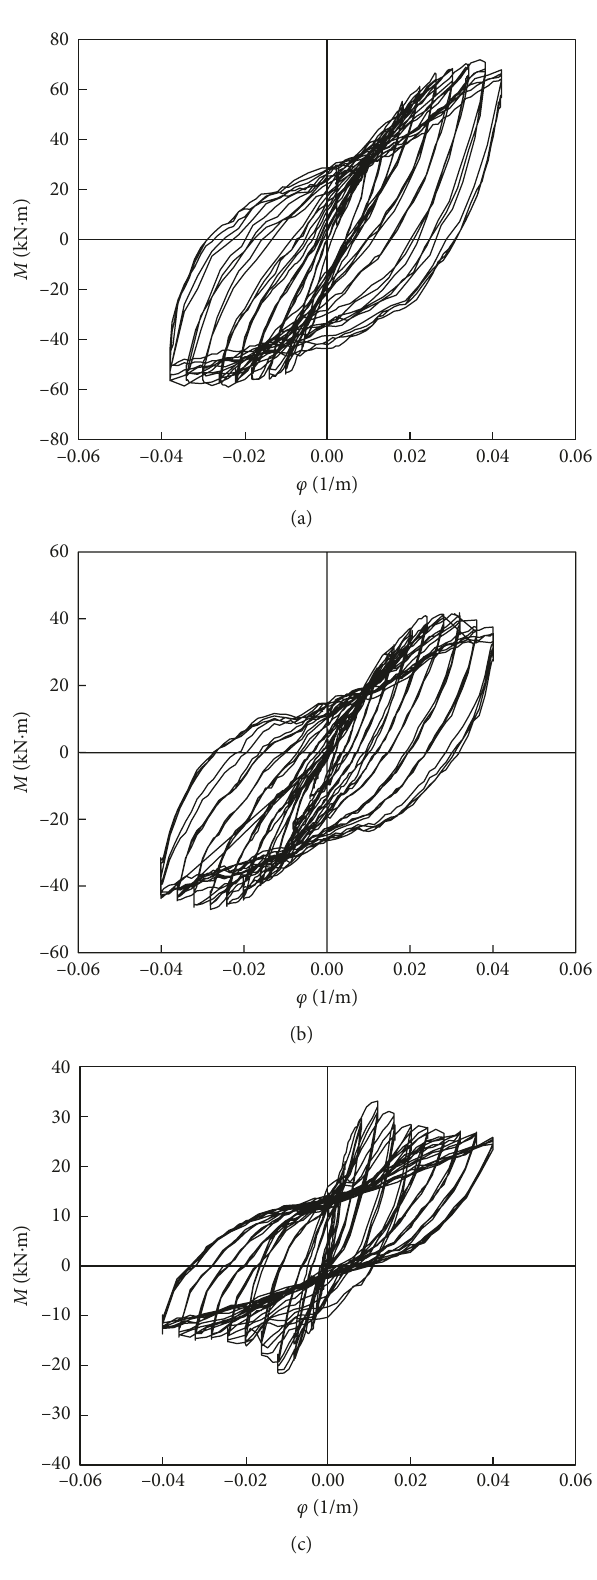
Figure 5: M - φ hysteretic loops of specimens. (a) Specimen DWHP-1, (b) specimen DWHP-2, and (c) specimen DWHP-3.